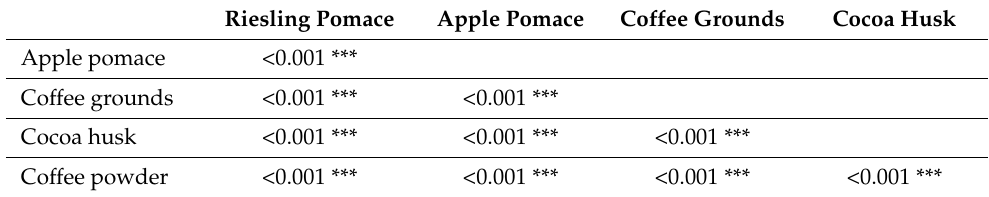
Table 4. p -Values of all pairwise multiple comparison procedures (Holm–Šid á k method) of